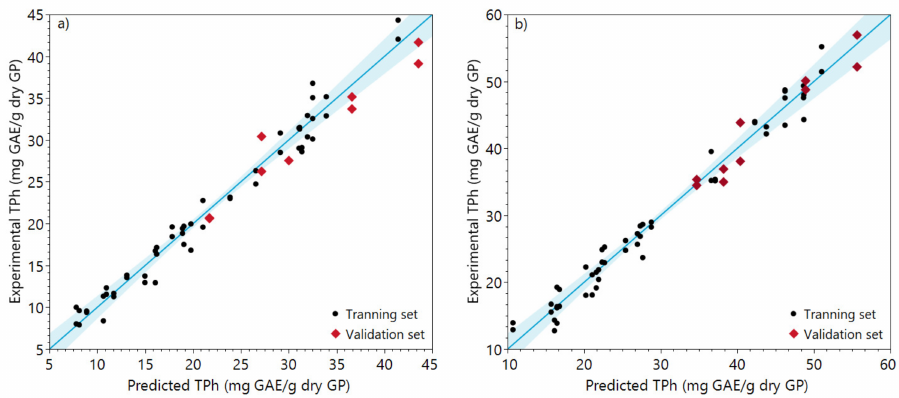
Figure 8. Comparison between experimental and predicted total phenolic content obtained from the central composite design of ( a ) ethanol and ( b ) acetone extraction.